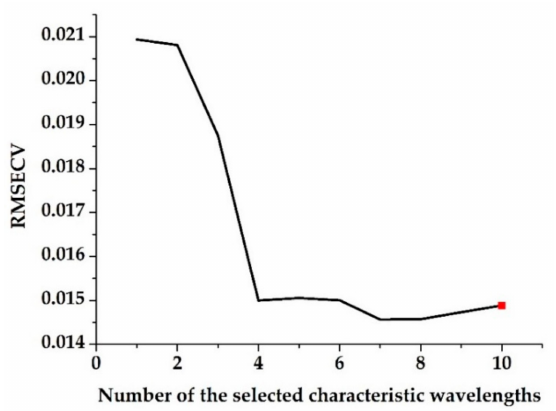
Figure4. Root-mean-squareerrorofleave-one-outcrossvalidation(RMSECV)changeswiththedi ff erent numbers of selected characteristic wavelengths found using the successive projections algorithm (SPA).